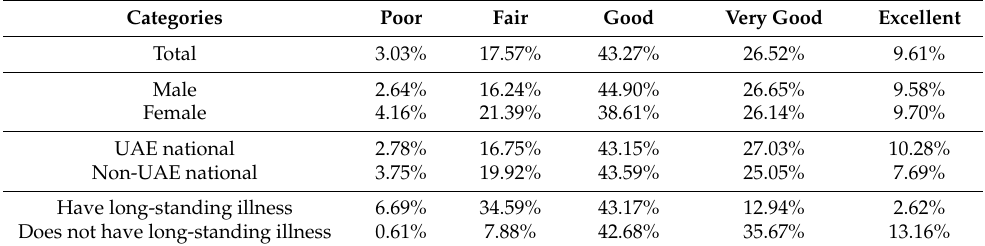
Table 2. General descriptive outcomes of self-rated